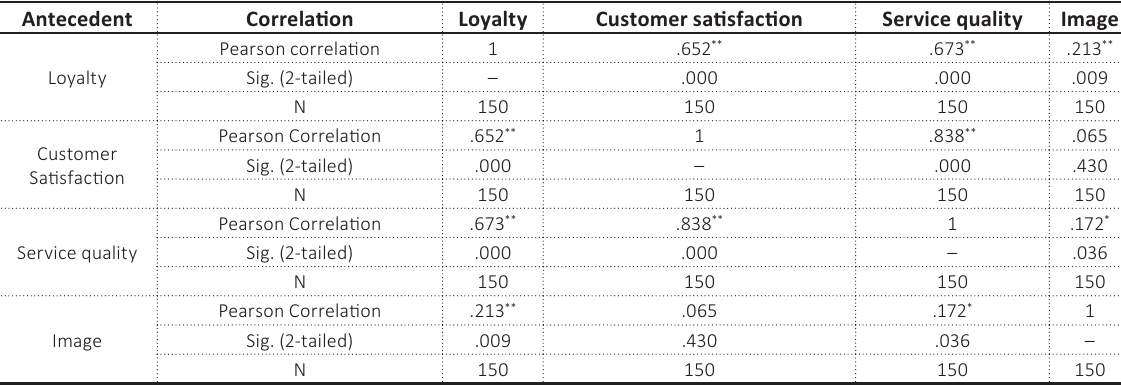
Table 2. Pearson correlations between antecedents Antecedent Correlation